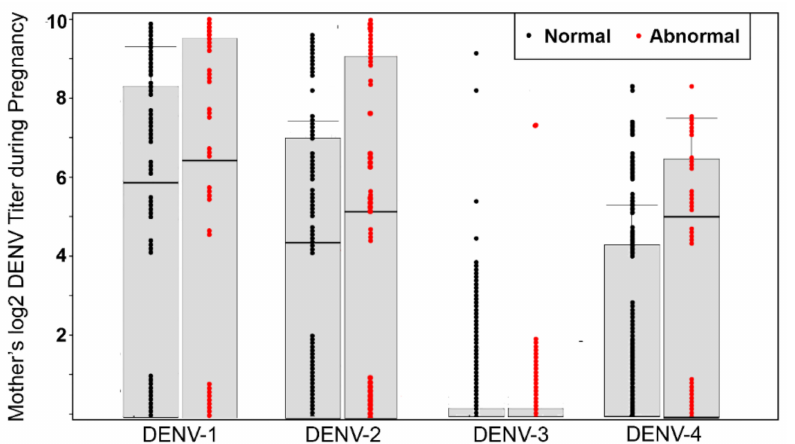
Figure 1. Effect of maternal DENV titer during pregnancy on adverse outcomes ( N = 114). The rate of abnormal births in mothers with DENV-neutralizing antibodies was different than that of mothers lacking such